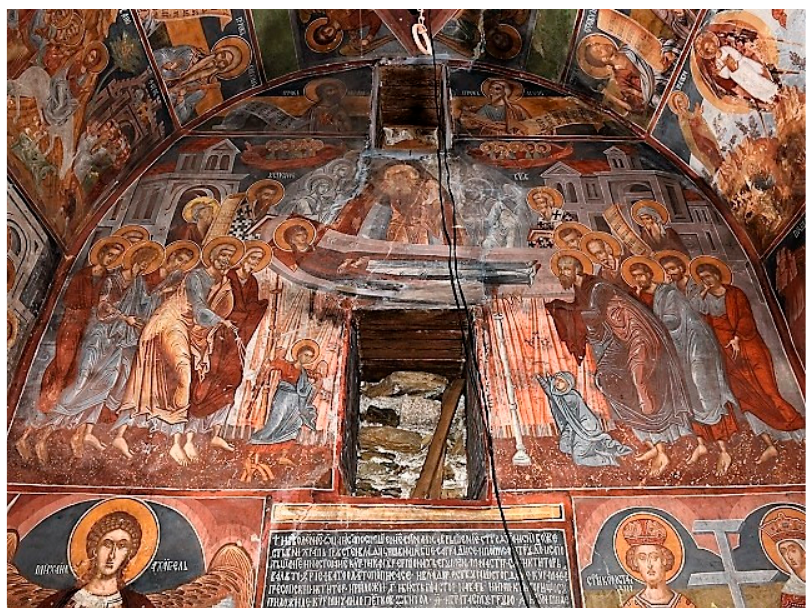
Figure 14. Dormition of the Theotokos , wall painting, 1606/1607, Church of the Virgin, Slimnitsa Monastery, Republic of North Macedonia. (Photo credit: Ivan Vanev, The Roads of the Balkan Painters and Post-Byzantine Artistic Heritage in Bulgaria Project, http://zografi.info/, accessed on 2 February 2023).